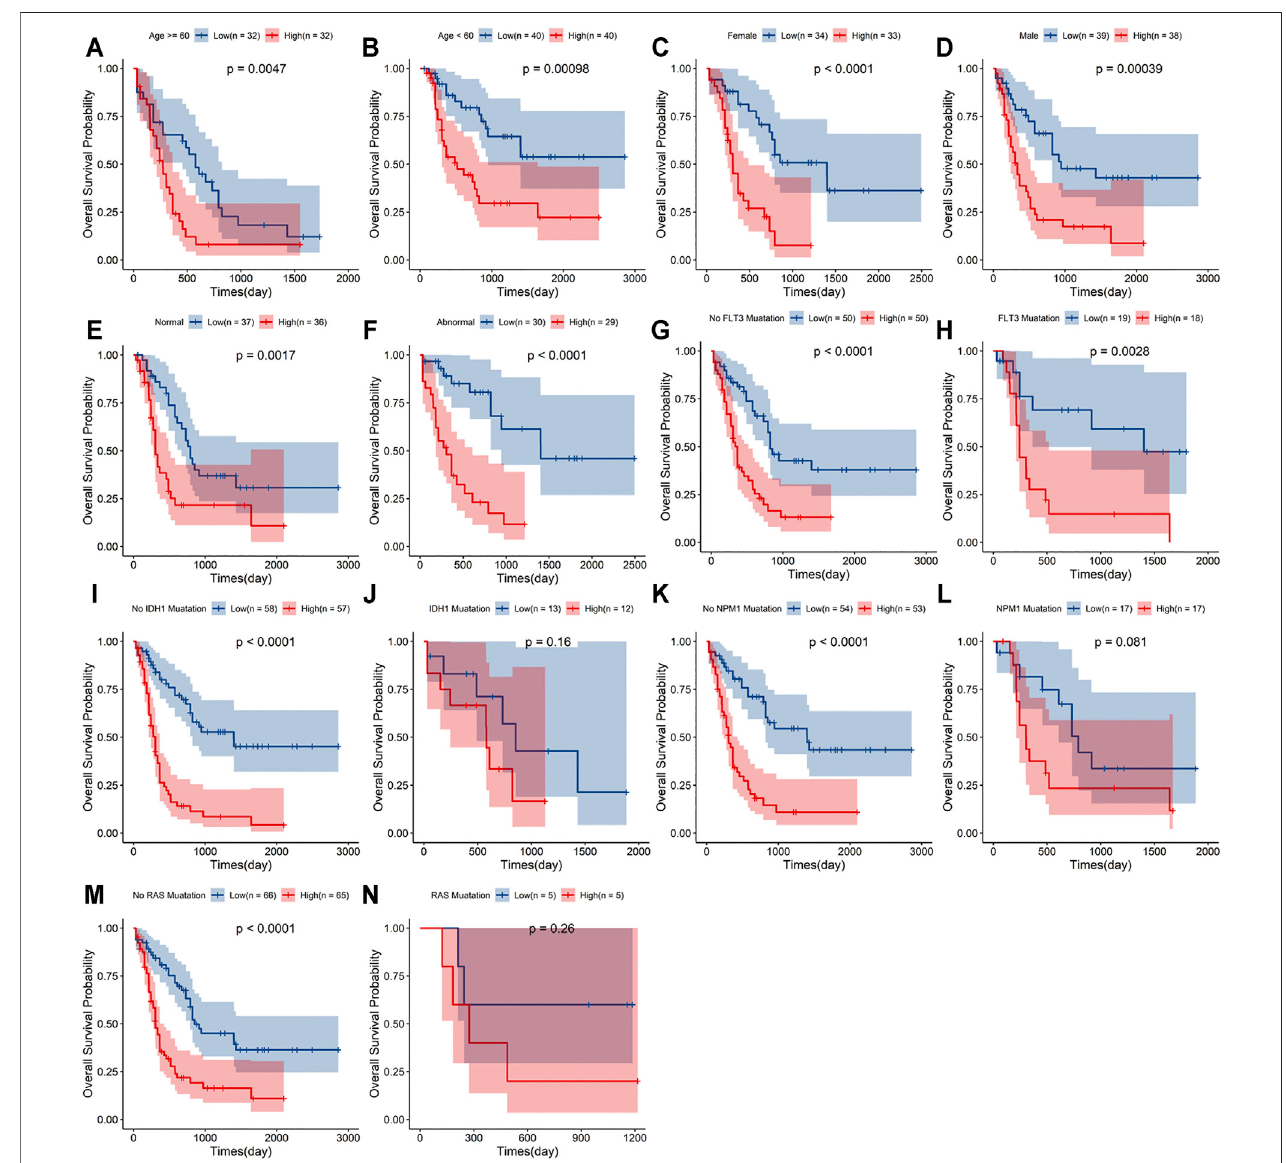
FIGURE 5 | Strati fi cation analyses of the signature based on prognosis-related clinicopathological characteristics. The survival outcomes of the patients strati fi ed according to age (A,B) , sex (C,D) , chromosomal abnormalities (E,F) , FLT3 mutations (G,H) , IDH1 mutations (I,J) , NPM1 mutations (K,L) and RAS mutations (M,N) in the two risk